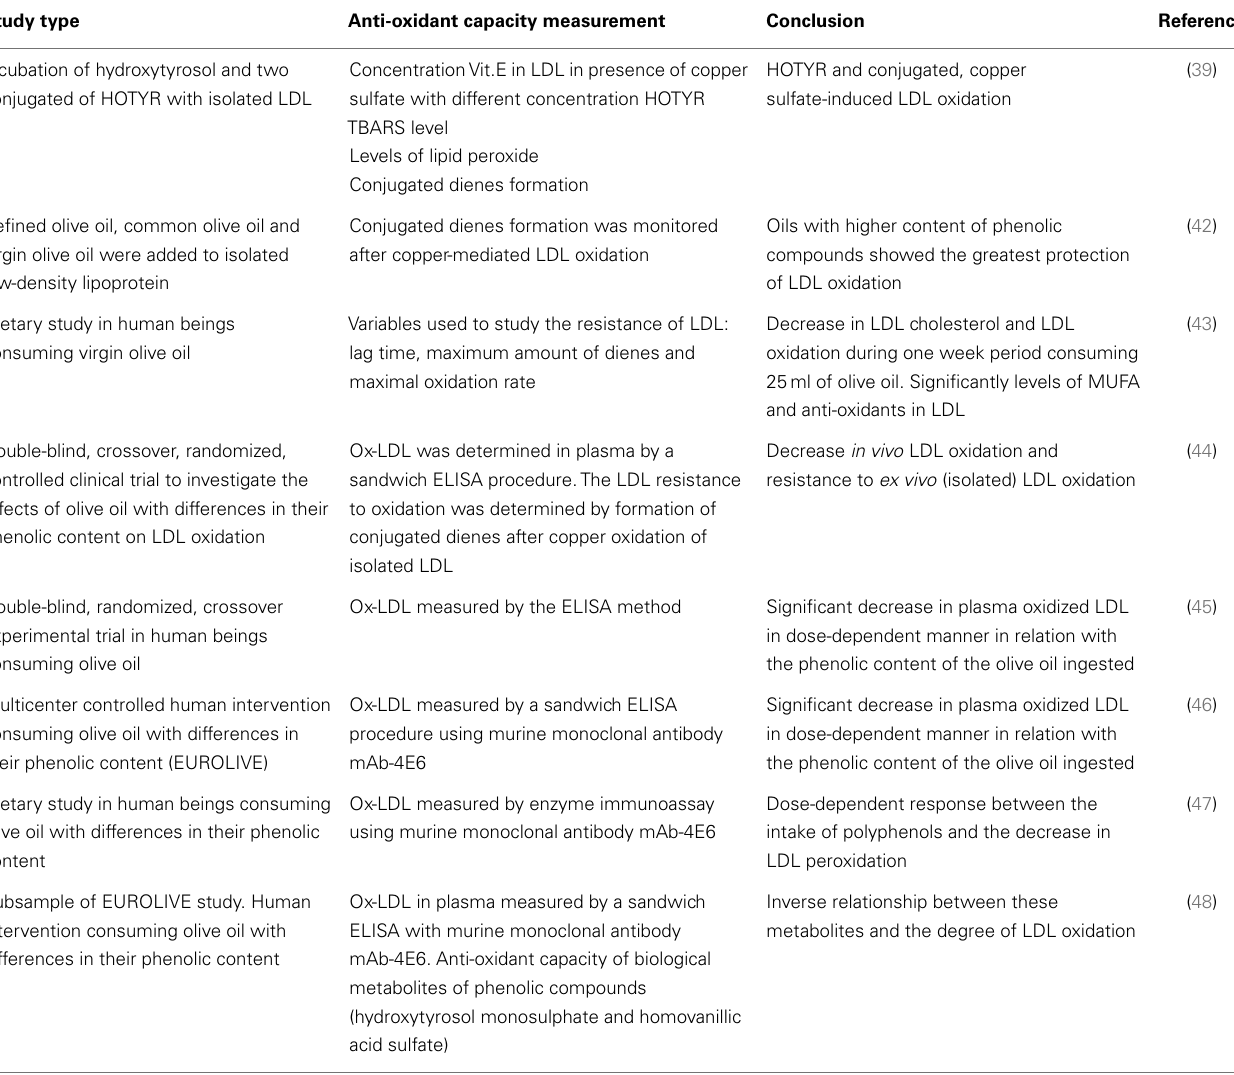
Table 1 | Protection of LDL from